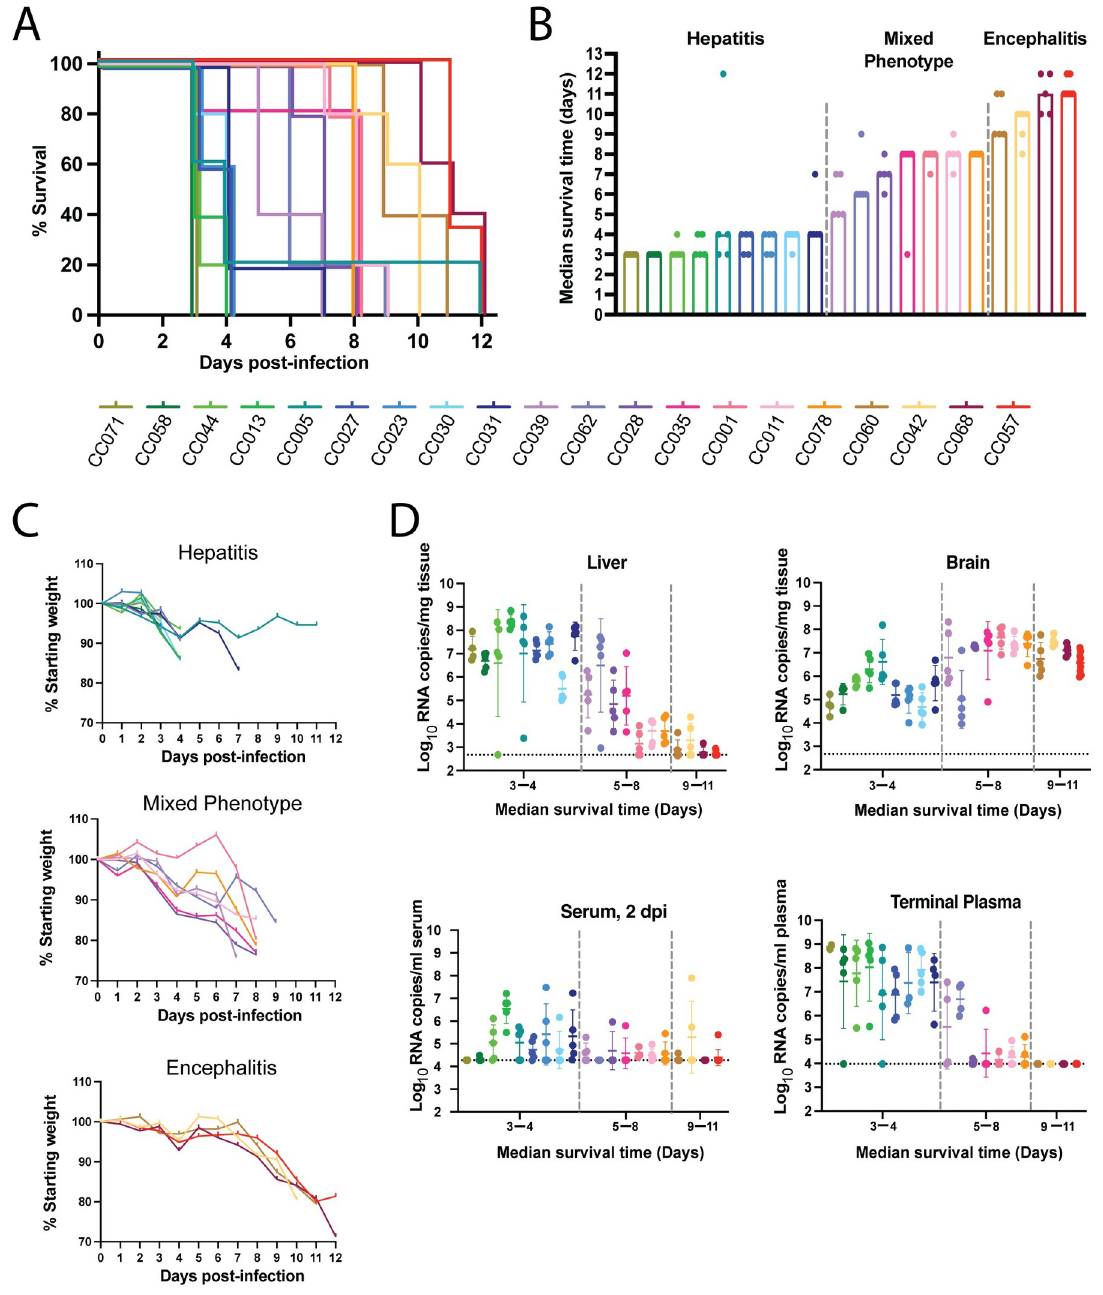
Fig 1. Disease phenotypes identified after RVFV infection in CC strains. A) Survival curve of 20 different CC mouse strains following RVFV infection. Each line represents 5 female mice apart from CC057 mice (n = 9, 5 female and 4 male). B) Median time to death across CC strains. C) Mean percent of starting body weight over the course of infection with CC strains split into three categories of disease. D) qRT-PCR based assessment of viral RNA loads in serum at 2 dpi and from tissues and plasma at time of euthanasia. CC strains are separated into three categories of disease by two dashed vertical grey lines. Serum and plasma viral loads were assessed if sufficient sample was present (n � 5 per CC strain) with data shown as geometric mean ± geometric SD. LOD of assays noted by dotted horizontal